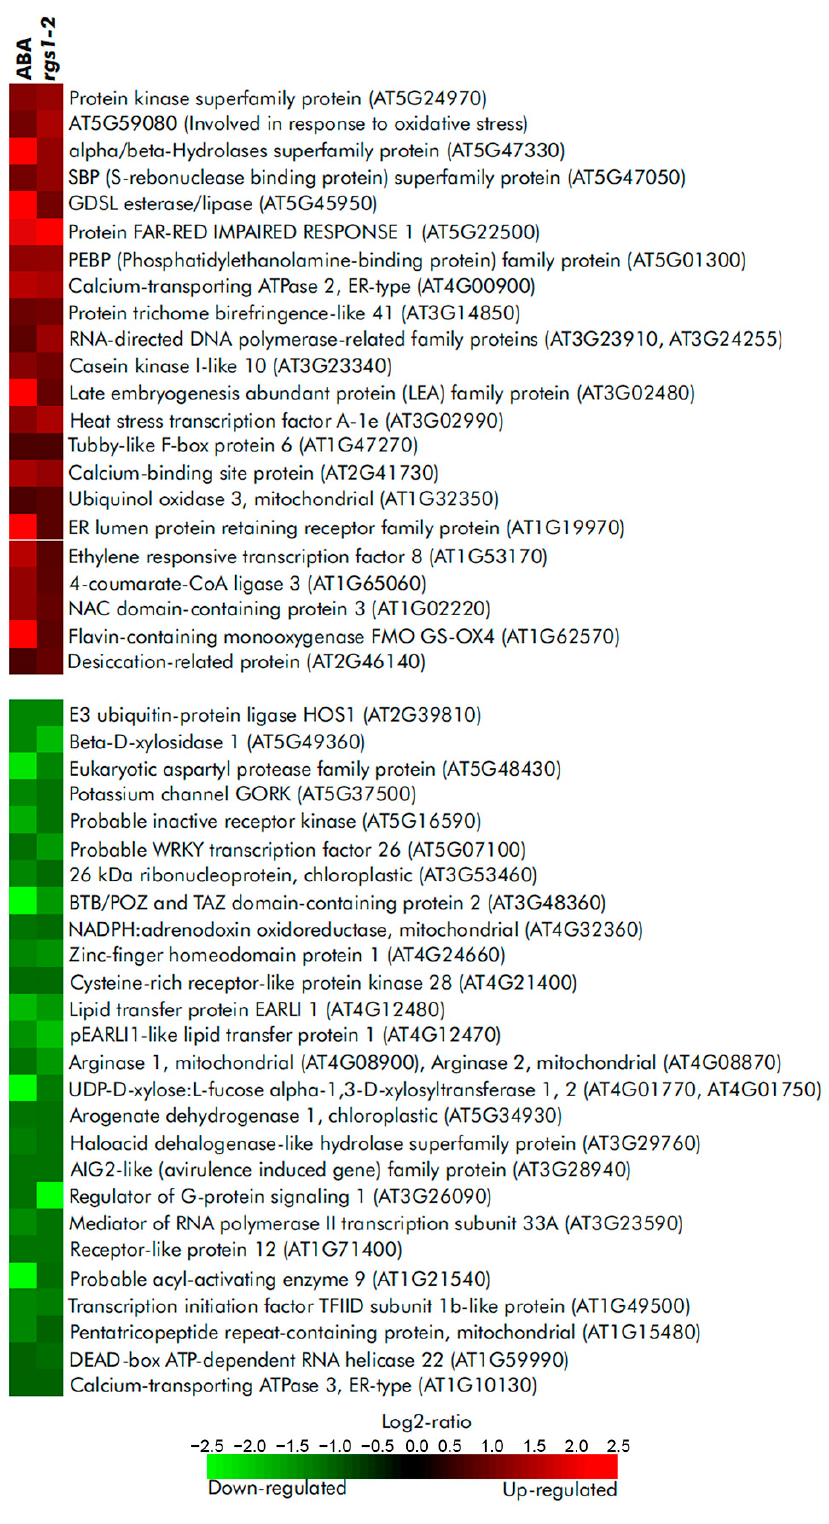
Figure 5. A set of similarly regulated genes in ABA-treated Col-0 Arabidopsis plants and in mock- treated rgs1-2 knockout mutants obtained using “Genevestigator” database [55]. Experiments ID used to mine the data are as follows: ABA, AT-00433; rgs1-2 , AT-00530. Changes in gene expression (log2-ratio) are color-coded according to the provided scale. Statistical treatment of the data was implemented by “Genevestigator” database. Original data resources